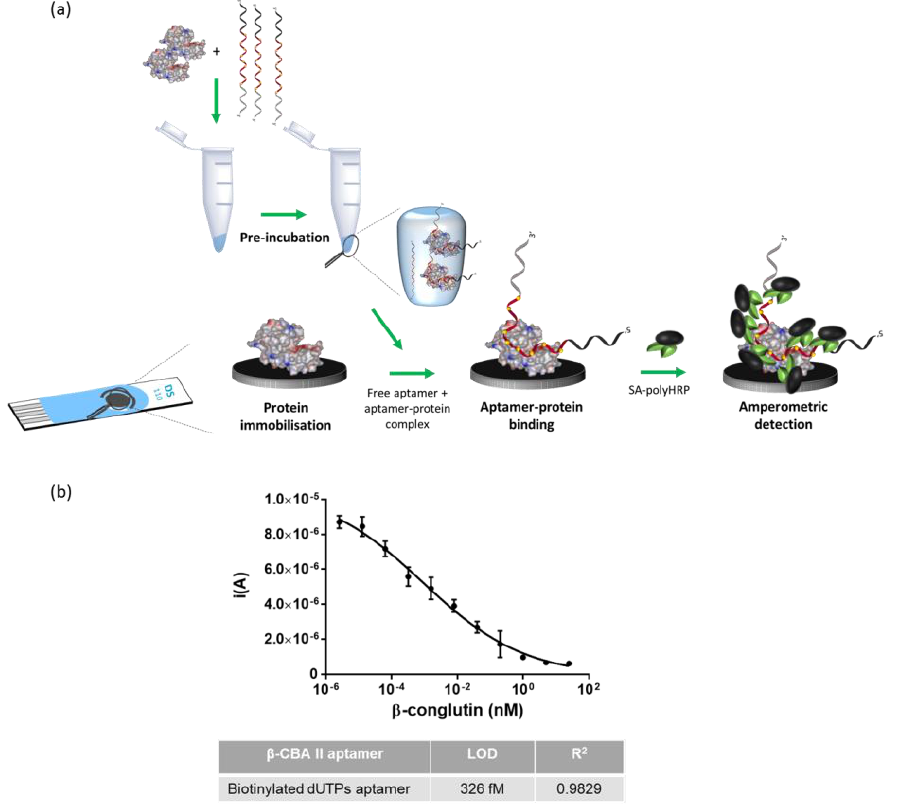
Figure 4. Competition assay on carbon screen-printed electrode: ( a ) schematic representation of the assay and ( b ) calibration